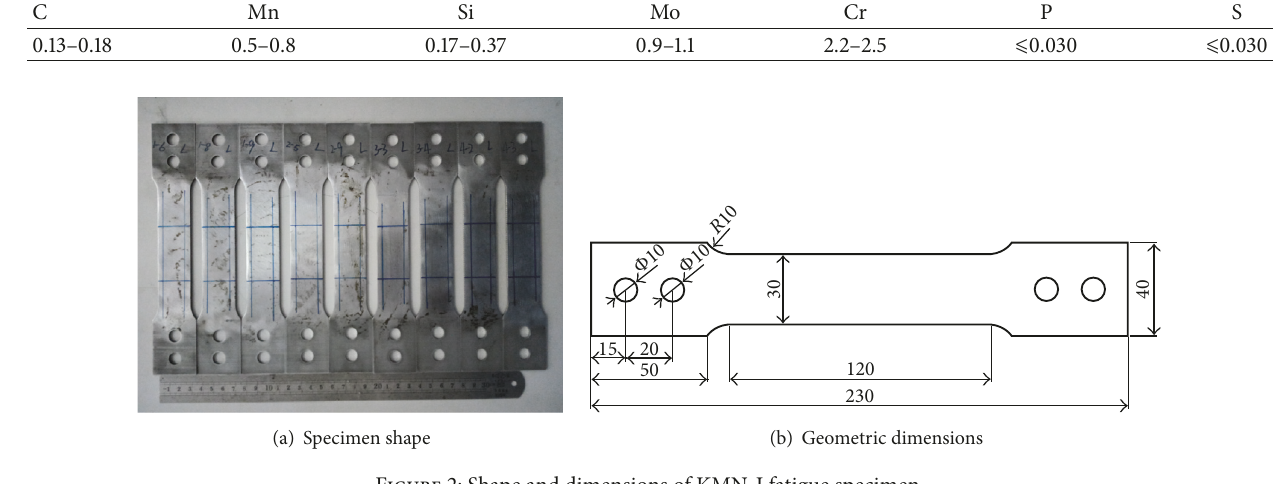
Figure 2: Shape and dimensions of KMN-I fatigue specimen.